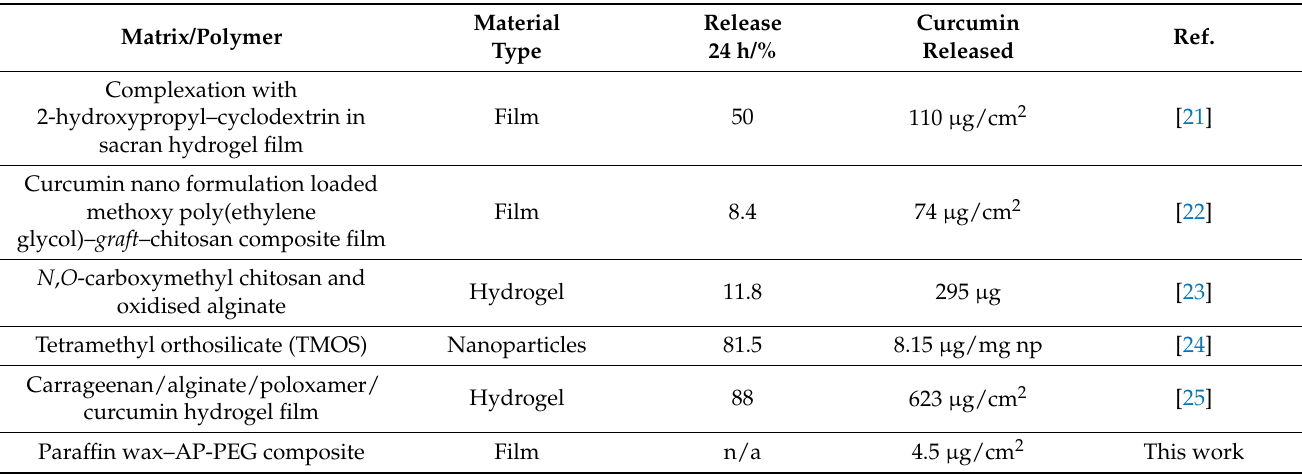
Table 1. Material strategies and their corresponding release characteristics for the controlled delivery of curcumin.